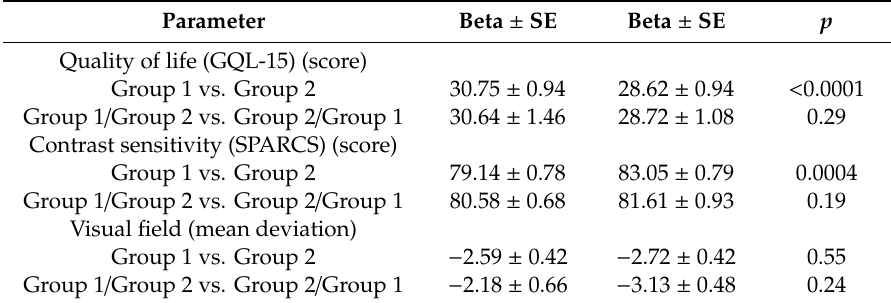
Figure 2. Quality of life (GQL-15 score) and contrast sensitivity (SPARCS score) changes over the follow-up period (baseline, month 4 and month 8). ( a,b ) Quality of life examined with GQL-15 questionnaire in Group 1 and Group 2 respectively. ( c,d ) Contrast sensitivity examined with SPARCS in Group 1 and Group 2 respectively. * p < 0.0001 for all. Table 3. Estimations of fixed e ff ects based on Grizzle’s